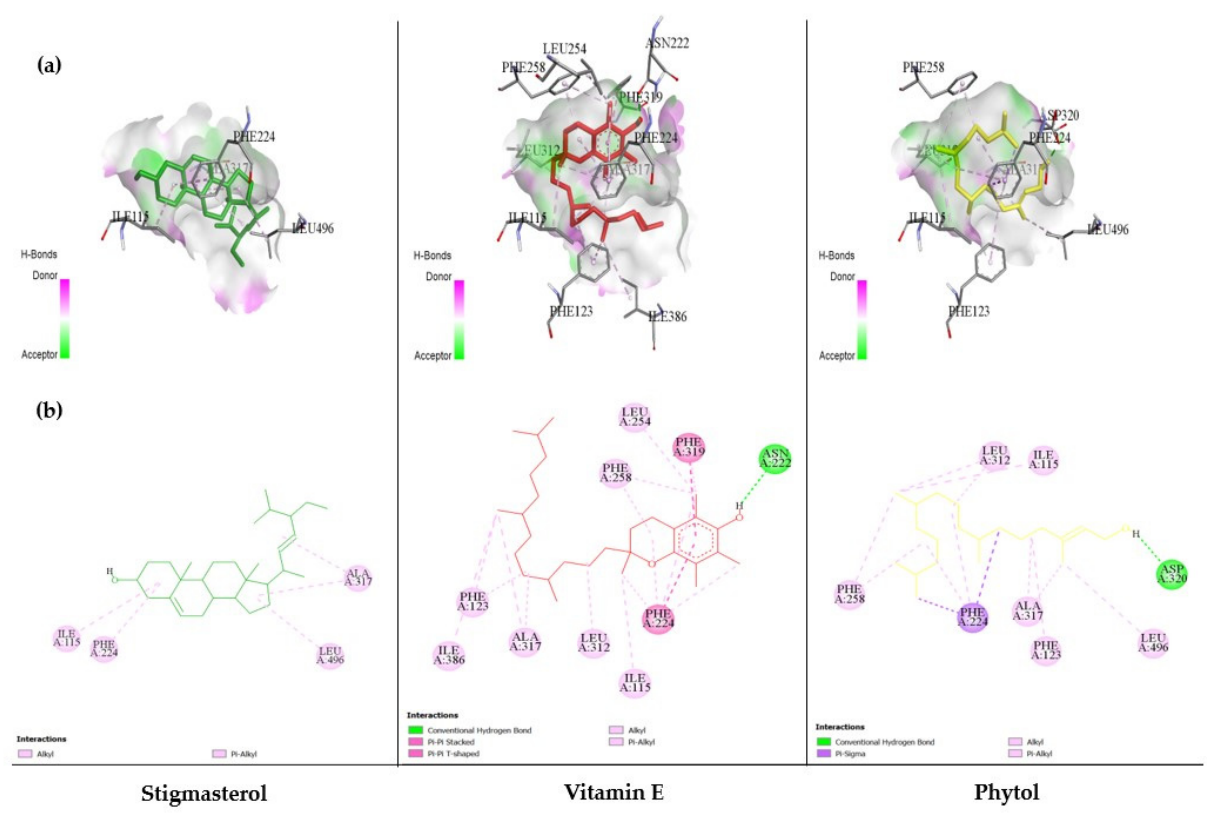
Figure 8. The results of the molecular docking study of CYP1A1 (4I8V) are represented by the 3D diagrams of interaction between each phytochemical and 4I8V ( a ) and by the 2D diagrams of phytochemical–receptor interactions ( b ). Table 3. Docking results of the phytochemical constituents with 1 CYP1A2 ( 2 PDB ID: 2HI4).